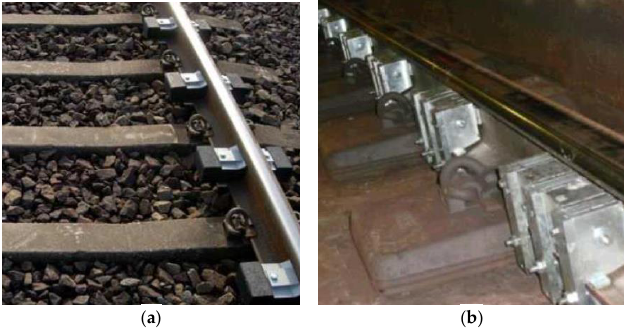
Figure 3. Examples of rail damping systems [2].